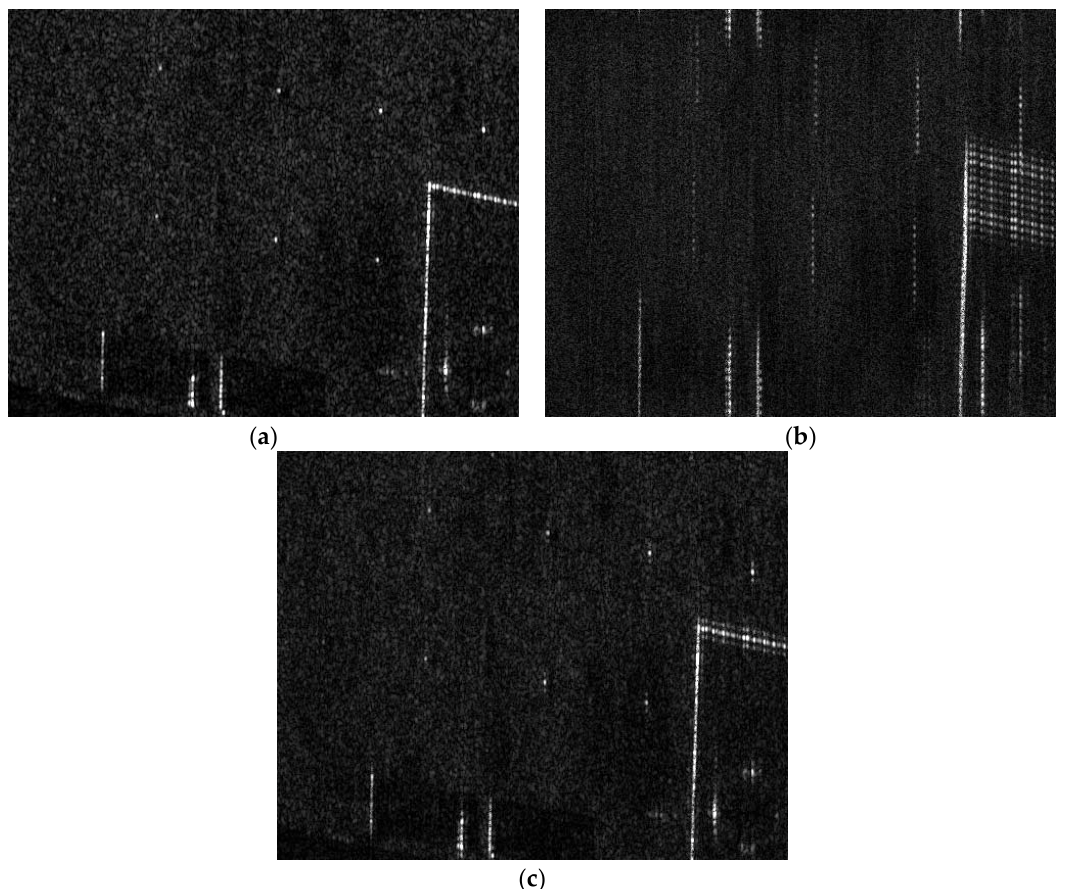
Figure 9. Imaging results of area targets. ( a ) Raw Image; ( b ) RD algorithm; ( c ) the proposed algorithm.